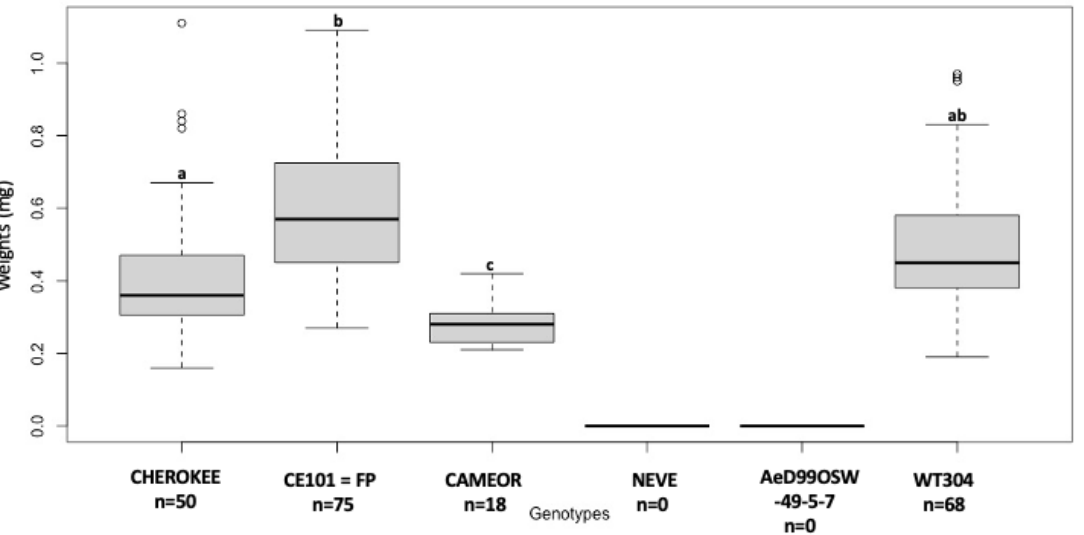
Figure 2. Larval body mass (8-day-old) of alfalfa biotype, LSR1, reared on different genotypes of P. sativum and on P. fulvum. Different letters indicate significant differences (one-way ANOVA, post-hoc comparisons using DGC, p < 0.05).